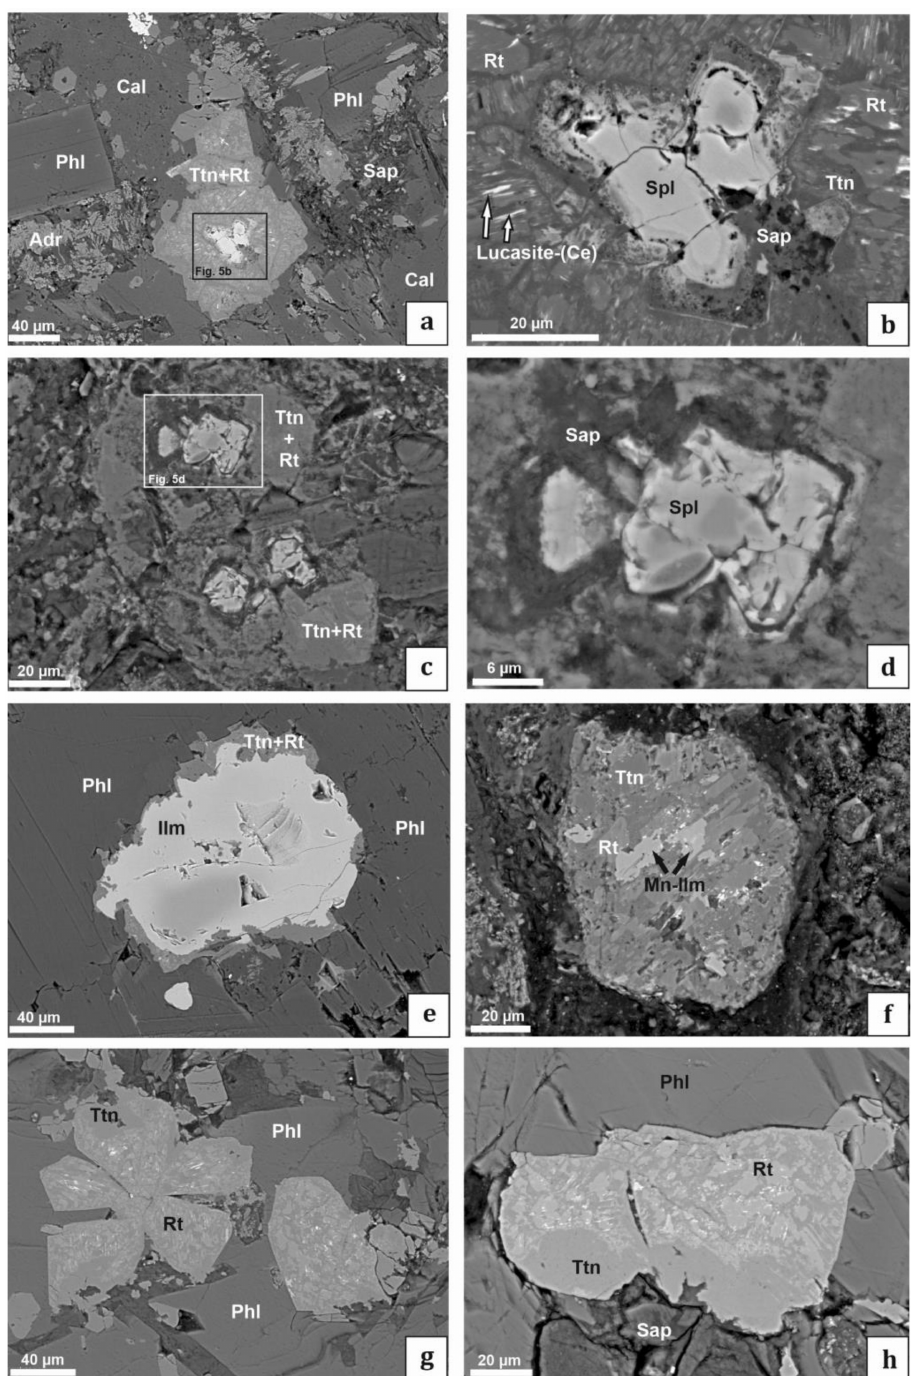
Figure 5. BSE images showing the textural relationships, morphology and internal textures of spinel, ilmenite, titanite and rutile: ( a ) Subhedral titanite grain with inclusions of rutile (light-gray), lucasite-(Ce) (brightest needles) and corroded spinel grain; ( b ) typical corroded spinel grain with reaction rim composed mainly of saponite; ( c ) several spinel grains in the center of titanite-rutile aggregate; ( d ) zoned spinel grain with high-Mg and low-Fe cores; ( e ) zoned corroded grain of ilmenite with rims of titanite-rutile intergrowths and core enriched in Mg; ( f ) inclusions of Mn-rich ilmenite (light gray) and rutile (gray) in titanite (dark gray); ( g ) morphology of titanite-rutile-lucasite-(Ce) intergrowths and ( h ) irregular distribution of rutile (light gray) and lucasite-(Ce) (bright needles) in titanite. Mineral abbreviations as in Figure 3; in addition: Adr = hydroandradite, Ilm = ilmenite, Rt = rutile, Spl =